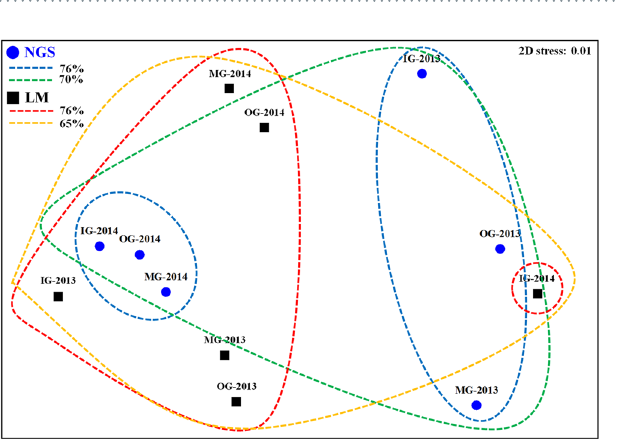
Figure 4. Non-metric multidimensional scaling plot based on next-generation sequencing (NGS as blue circles) and microscopy (LM as black square) results of the Bray–Curtis dissimilarity at the stress of 0.01 level. IG, inner group; MG, middle group; OG, outer